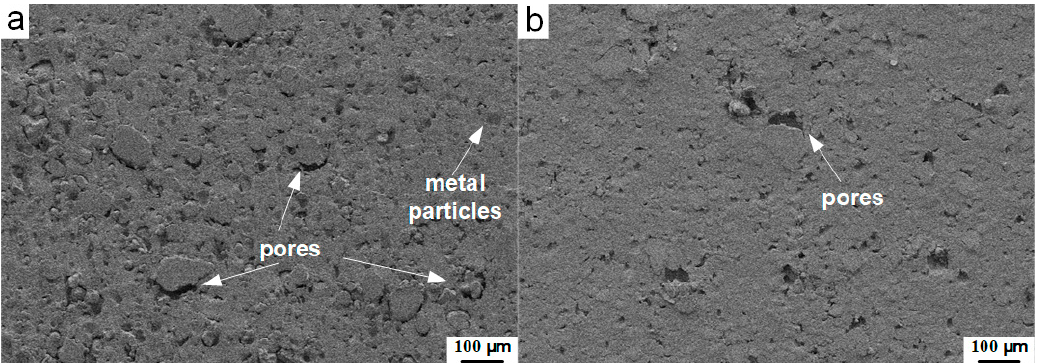
Figure 3. Cross-sectional mesoscale images of the type C cold isostatic pressed (CIPed) PTFE/Al/W samples pressed under different pressures: ( a ) 10 MPa; ( b ) 100 MPa.